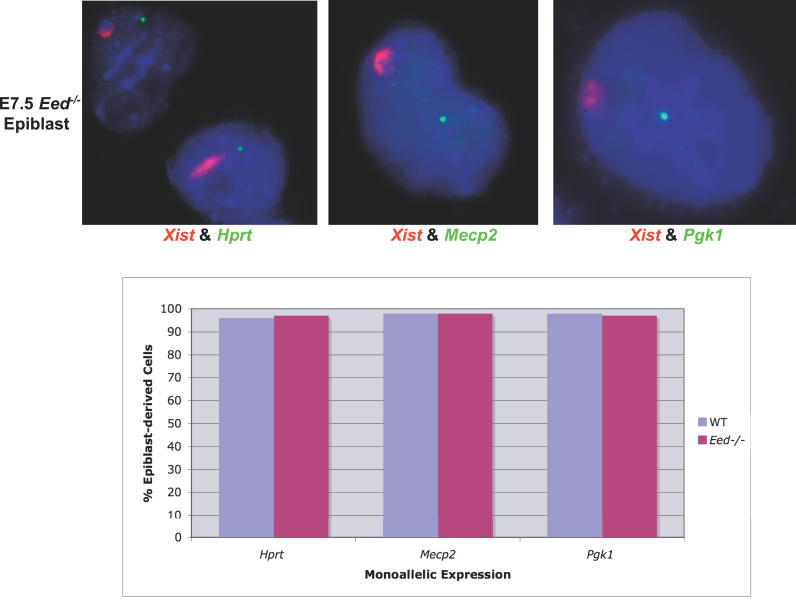
Monoallelic Expression of Endogenous X-linked Genes in Epiblast Derivatives of Female E7.5 Eed
−/− EmbryosFISH detection of Xist, Hprt, Mecp2, and Pgk1 transcripts indicates that endogenous X-linked genes are expressed from one X-chromosome in Eed
−/− epiblast-derived cells. Epiblast derivatives from both WT and Eed
−/− E7.5 embryos show similar rates of monoallelic X-linked gene expression (>96%). Hprt, Mecp2, and Pgk1 are invariably expressed from the chromosome other than the one marked by Xist RNA coating, which denotes the Xi. Sixty-eight to 87 nuclei were counted for each sample.